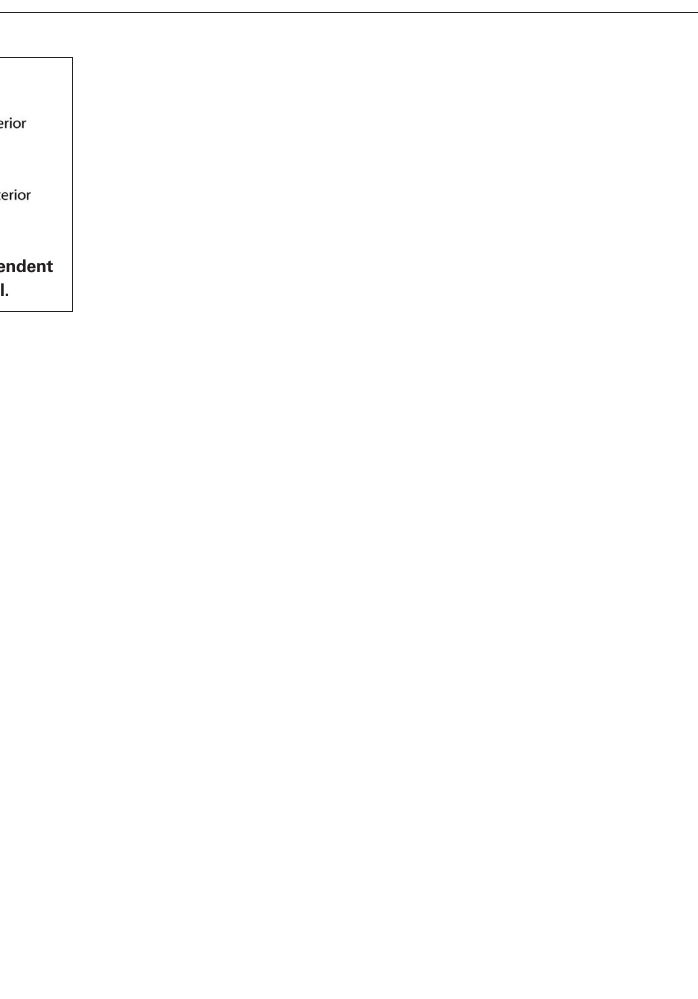
Figure A3 | Contralateral effects are slightly strengthened by eliminating those subjects who were least successful at fixating (compare with Figure 3 of main text). Contours identify regions where contrasts differ significantly from baseline levels (posterior probability > 0.99).